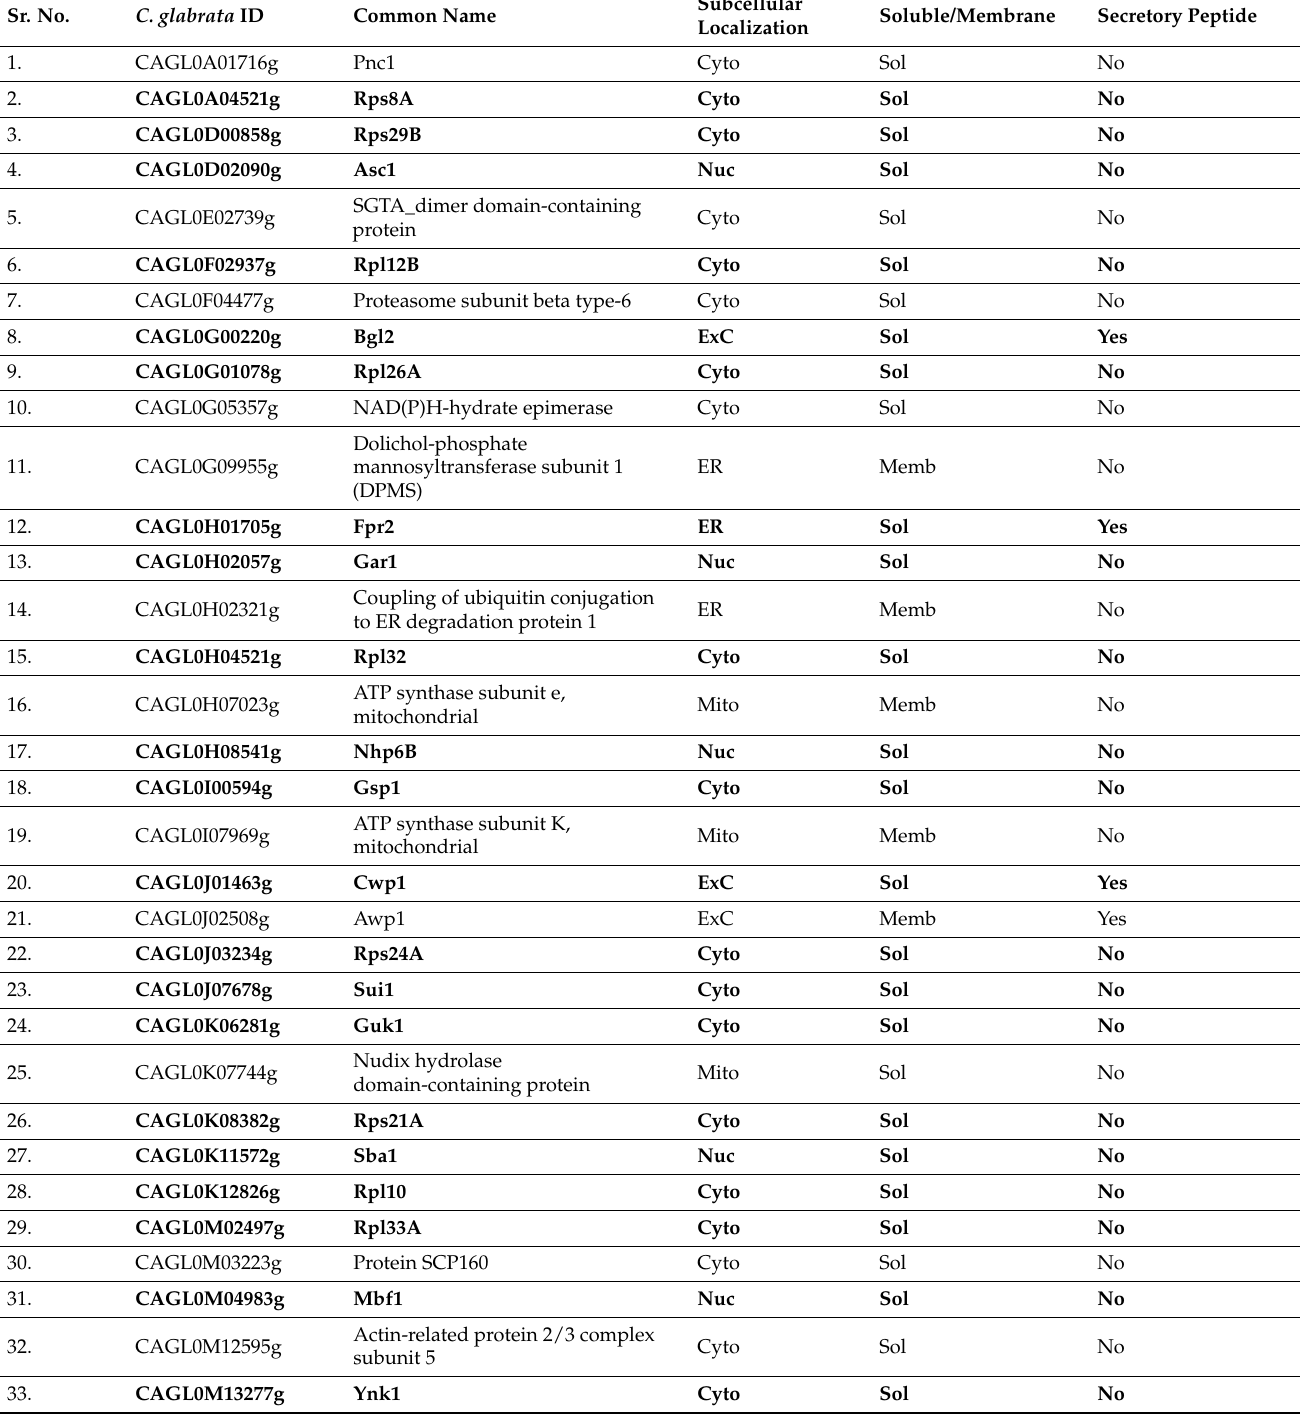
Table 2. List of predicted antigenic proteins present in the C. glabrata